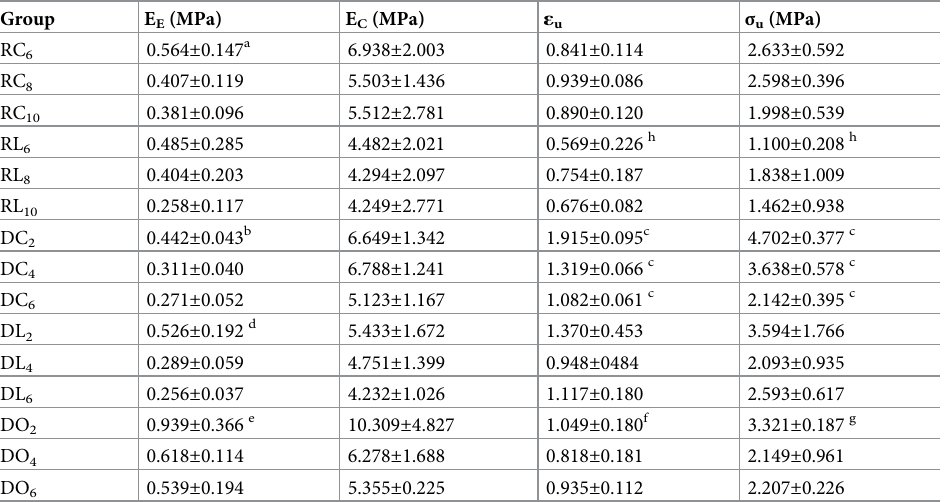
Table 4. Mean physical properties in the different groups.